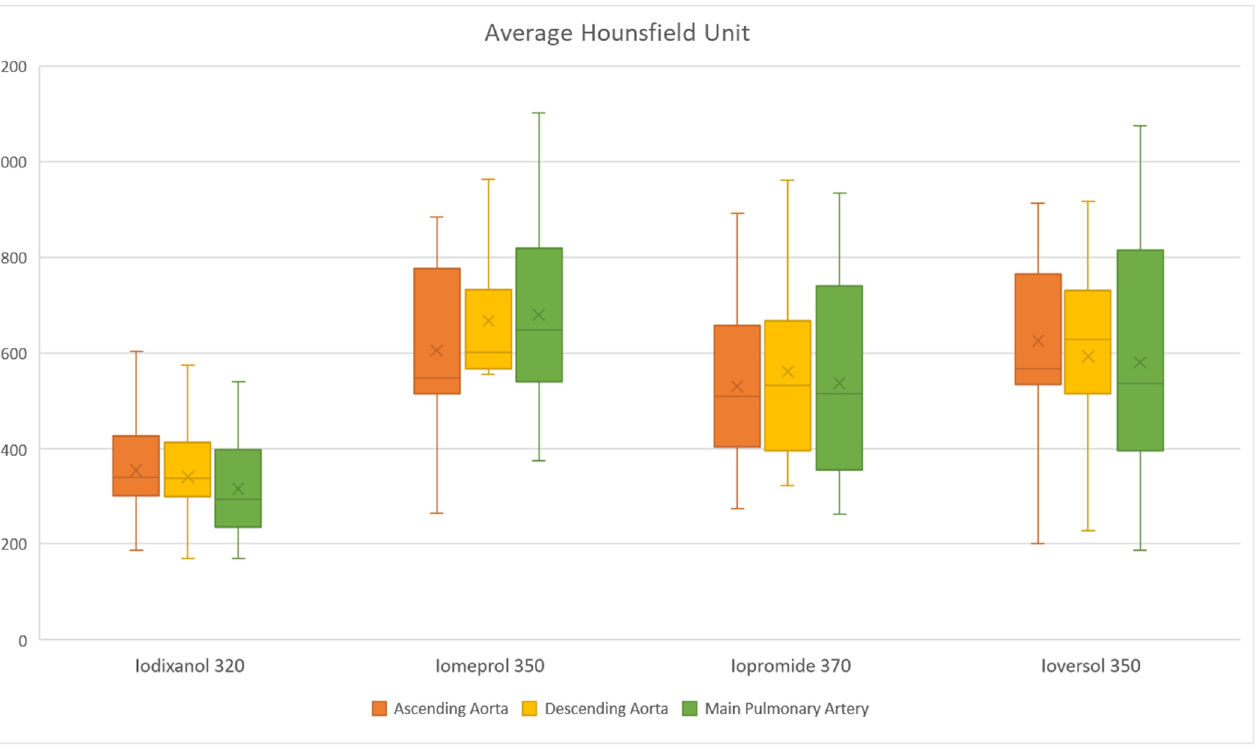
Table 3. HU average values of the large vessels.